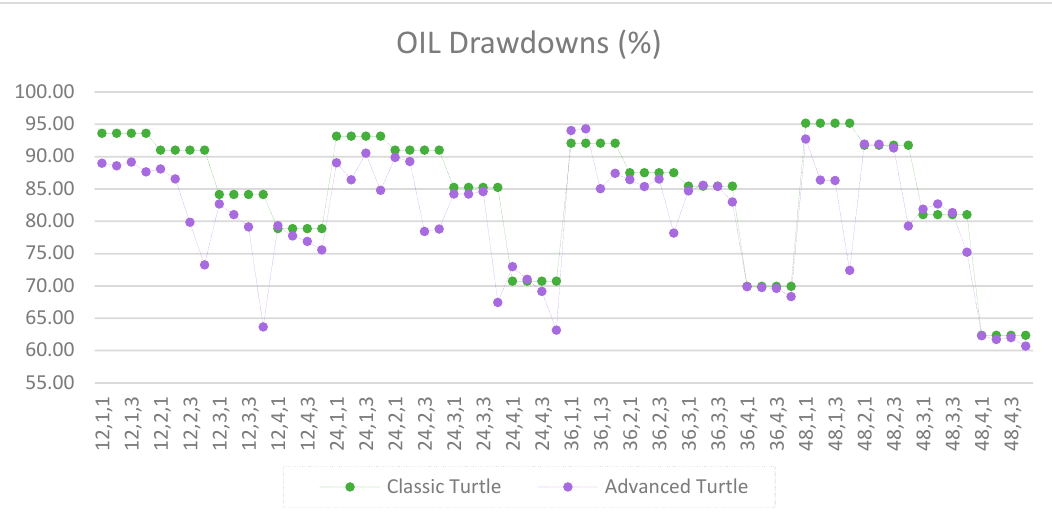
Figure A29. Net profits of OIL between the classic and the advanced Turtle systems for every combination of N, X, Y for the medium parameters (40, 80).